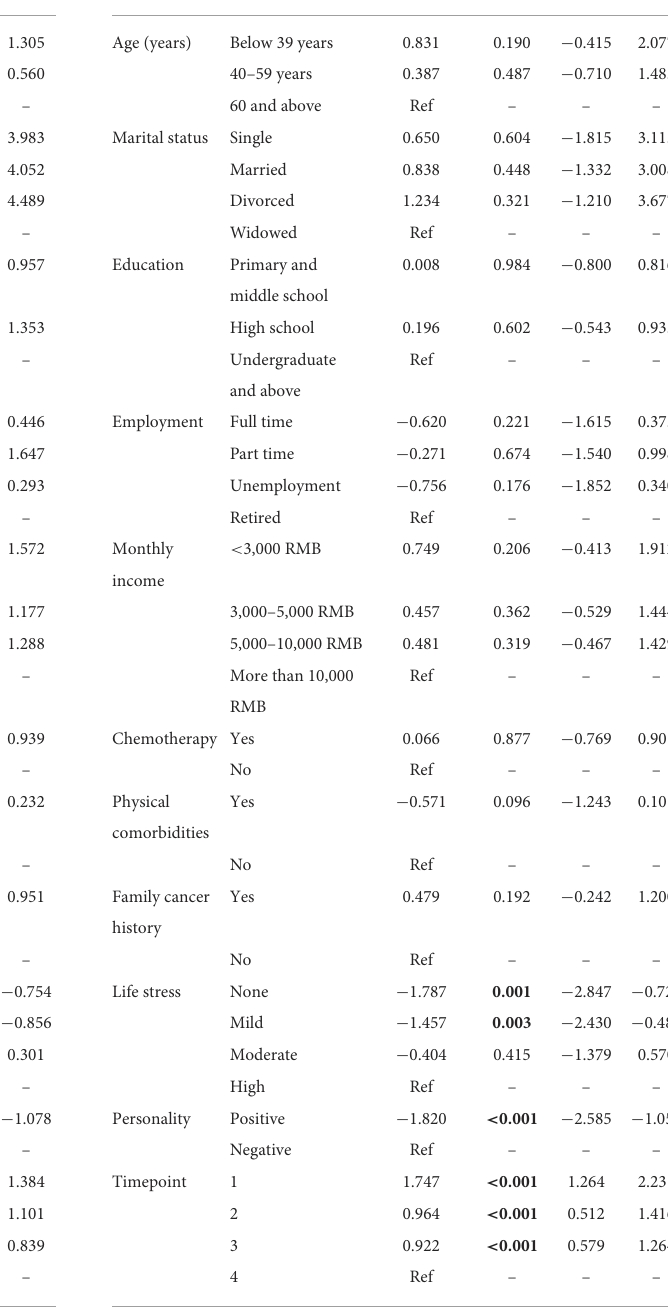
Bold:statisticallysignificant;1USdollar ≈ 6.3RMB.